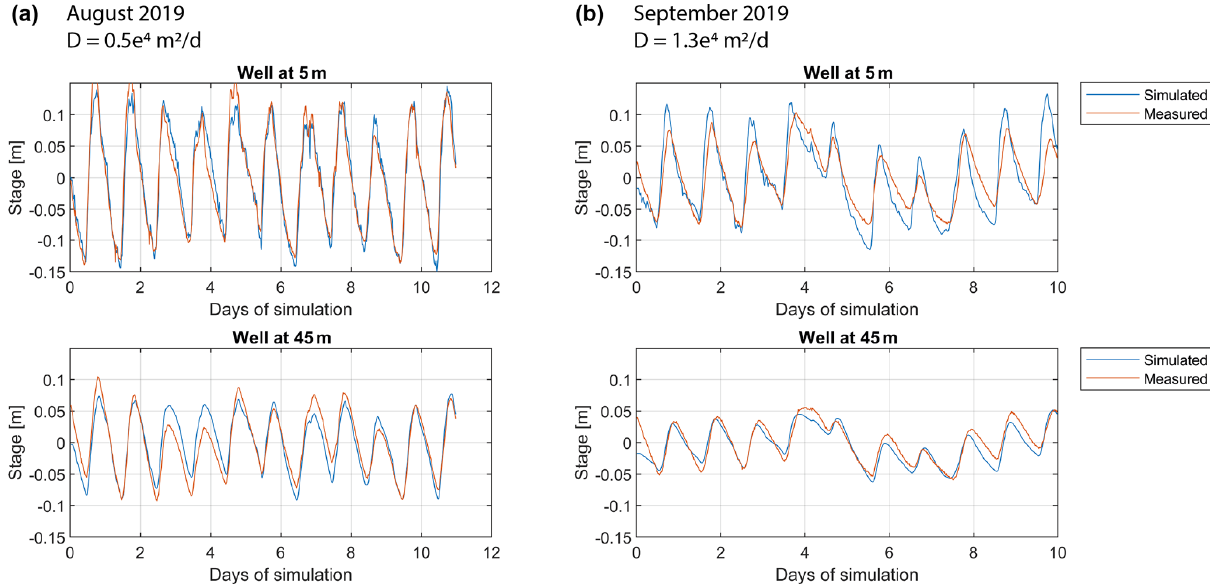
Figure A2. Measured and simulated water head variations for piezometers along the upstream transect “ D ” for the best calibration of the diffusion parameter D and for (a) the high-flow condition in August 2019 and (b) the lower-flow condition in September 2019.